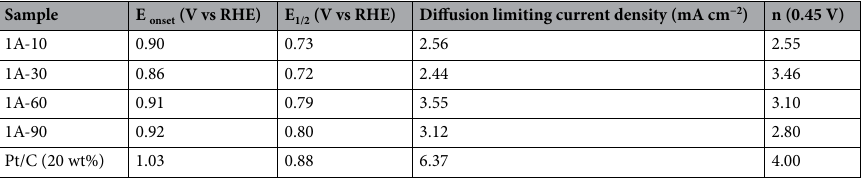
Table 4. ORR performance parameters of series 1A-T and commercial Pt/C catalyst tested in alkaline media.